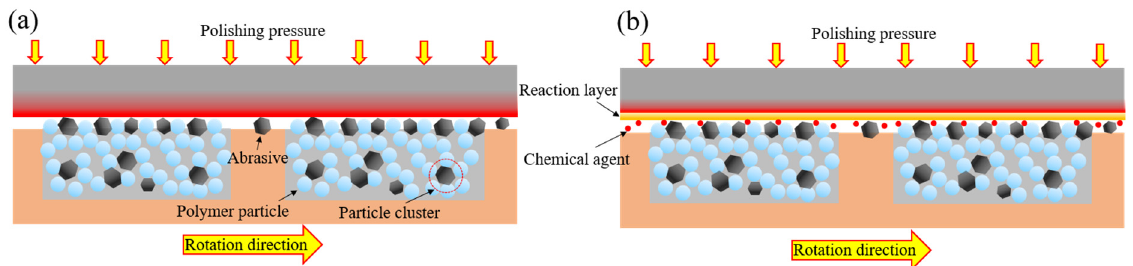
Figure 1. Schematic illustrations of the polishing principle: ( a ) Shear Dilatancy Polishing (SDP); ( b ) Chemical enhanced Shear Dilatancy Polishing (C ‐ SDP).